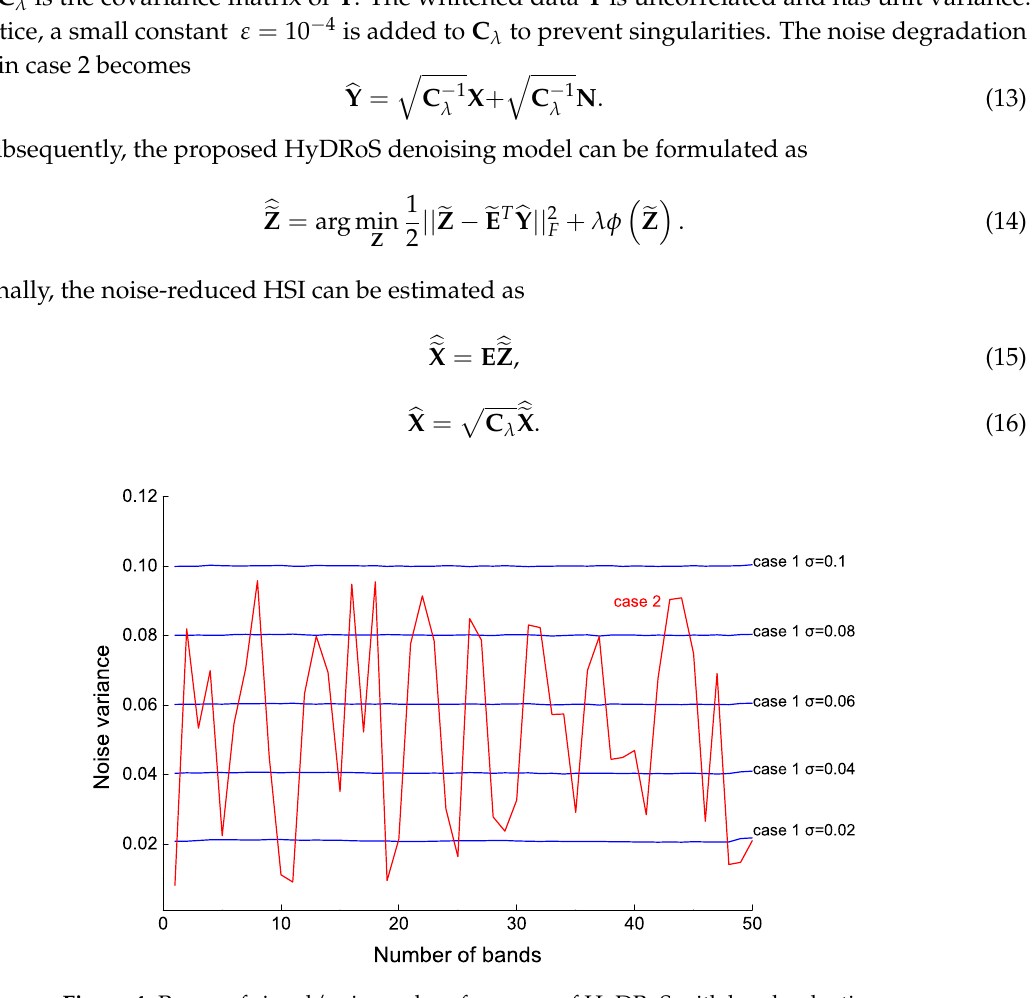
Figure 4. Power of signal/noise and performance of HyDRoS with band reduction.